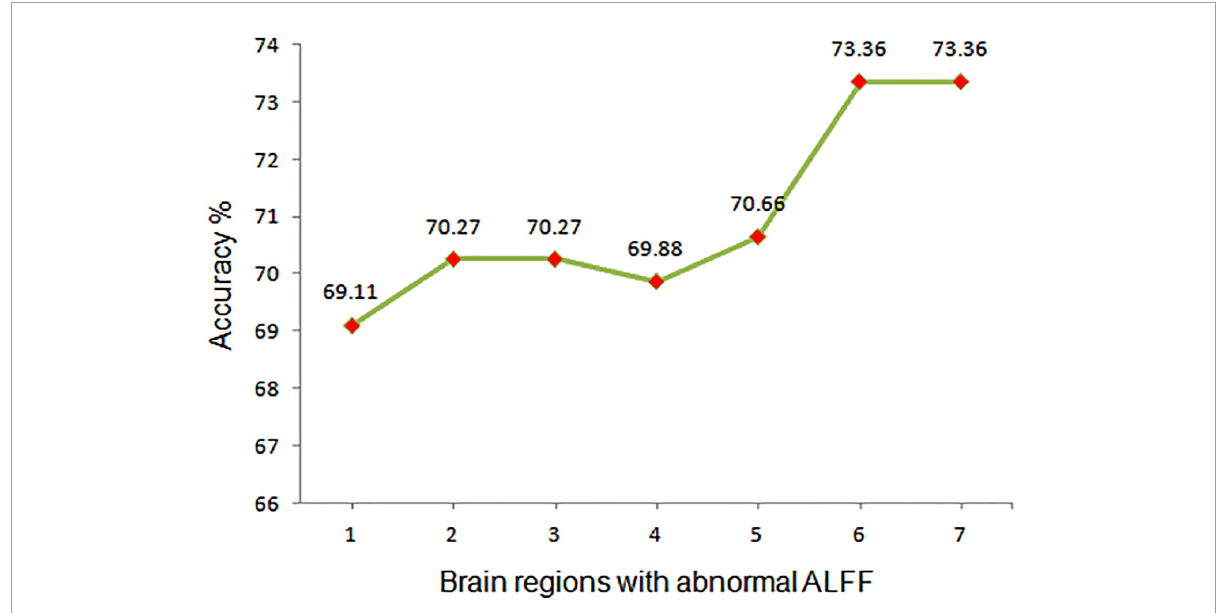
FIGURE3 Assessment of the accuracy of utilizing abnormal ALFF values in different regions of the brain to differentiate between SCH patients and HCs. ALFF, amplitude of low-frequency fluctuation; 1, right cerebellum; 2, middle temporal gyrus; 3, right middle temporal gyrus; 4, left fusiform; 5, left anterior cingulate cortex; 6, bilateral precuneus; 7, left angular gyrus.